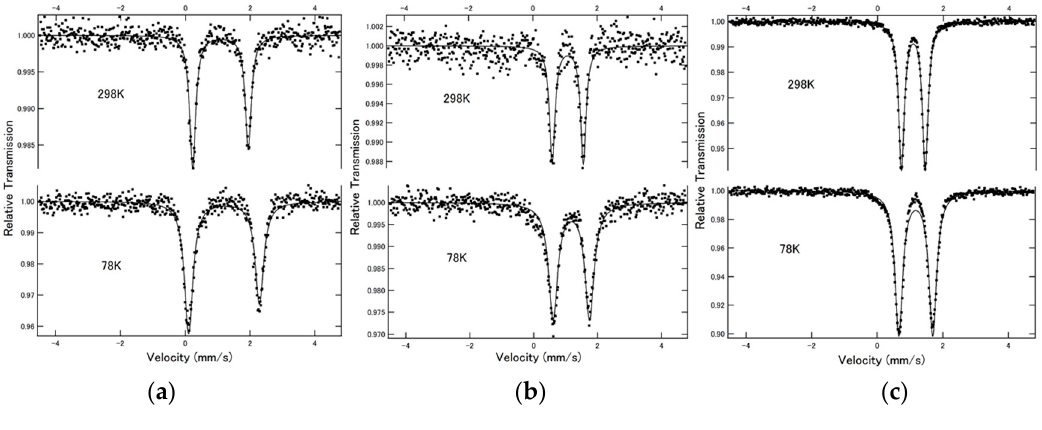
Figure 1. 57 Fe Mössbauer spectra of ( a ) 1 ; ( b ) 2 ; and ( c ) 3 . Table 1. Mössbauer parameters for complexes 1 , 2 , and 3 .